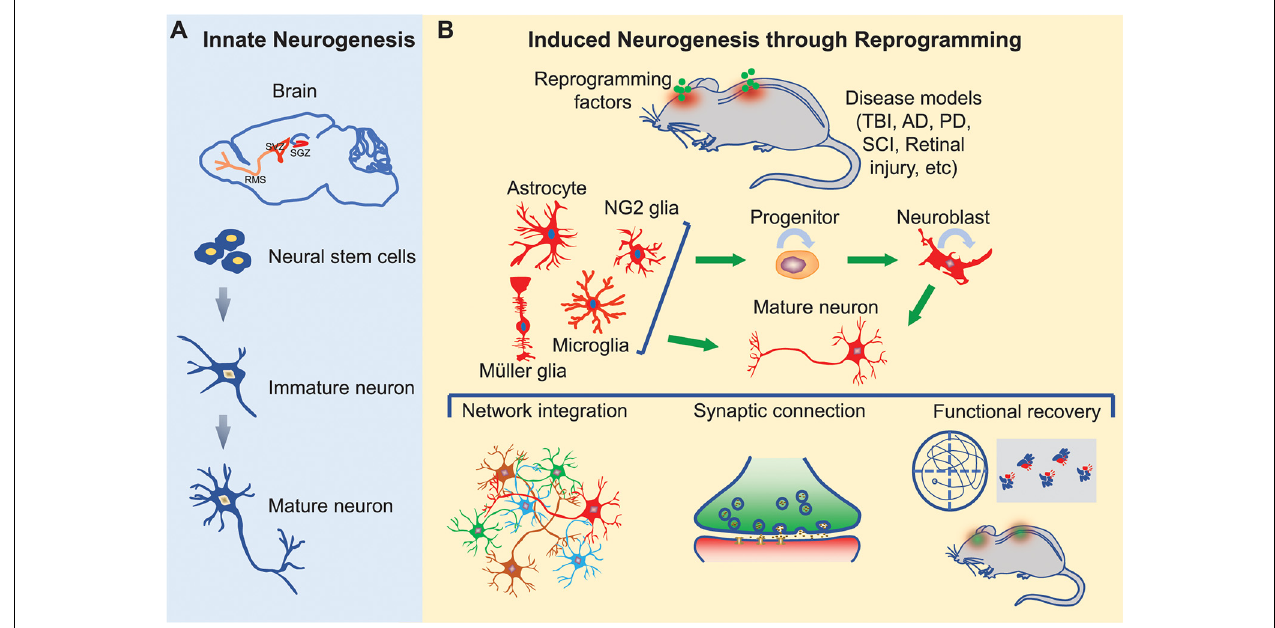
FIGURE 1 | Innate and induced neurogenesis in the adult central nervous system. (A) Innate adult neurogenesis mainly occurs in the subgranular zone (SGZ) of the hippocampal dentate gyrus and the subventricular zone (SVZ) of the lateral ventricle. Neural stem cells in these regions generate neurons under physiological and certain pathological conditions. Neurons generated in the SGZ remain in the dentate gyrus, whereas neurons originated from SVZ migrate along the rostral migratory stream (RMS) into the olfactory bulb. (B) Induced adult neurogenesis occurs through cell fate reprogramming in multiple regions of the brain, spinal cord, and retina. Resident glial cells can be directly reprogrammed into mature neurons or progenitors. The induced progenitors can expand through proliferation and eventually give rise to mature neurons. These induced neurons may integrate into the neural networks and promote functional recovery following neural injury or